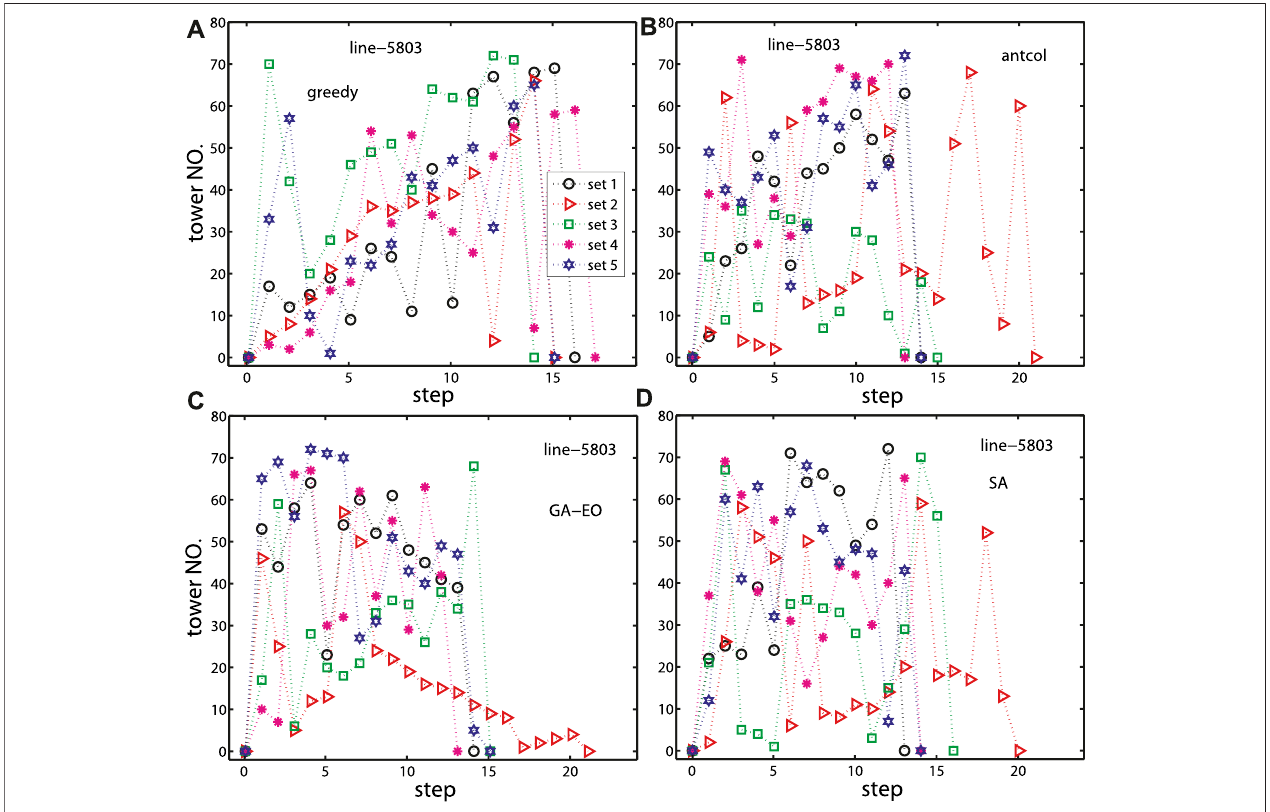
FIGURE 8 | (color online) Optimal inspection paths with our framework with (A) greedy, (B) antcol, (C) SA and (D) GA-EO. k = 5 for line-5803. p = 0.05 for the greedy algorithm. Here, the coordinate (0, 0) is the starting point, namely, the of fi ce.